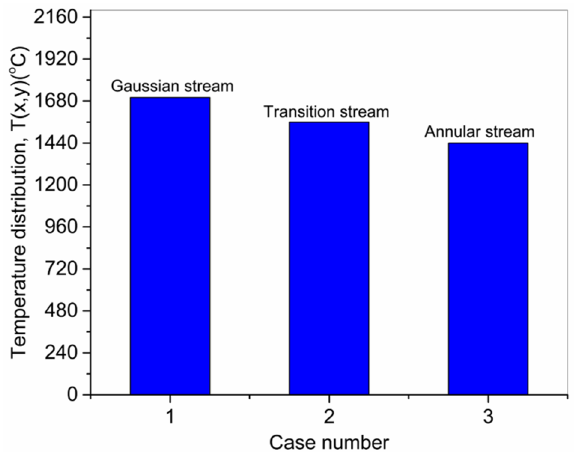
Figure 11. Effect of Ti6Al4V alloy powder stream on average maximum temperature at the substrate when P = 400 W, v l = 0.3 m/min, and P F = 5.0 (g/mm 3 ).